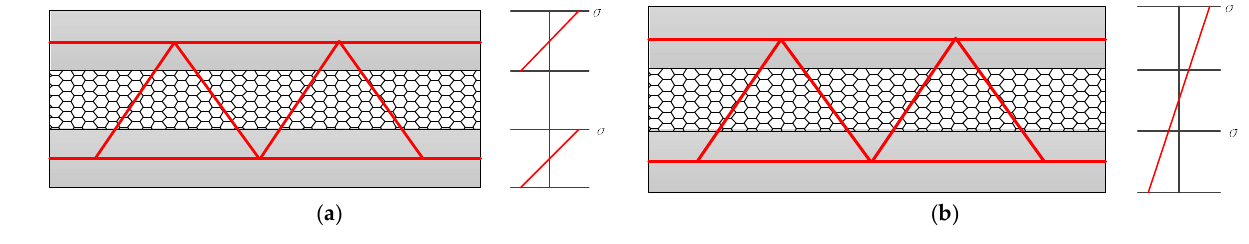
Figure 16. Strain distributions of the sandwich wall. ( a ) K = 0. ( b ) K = 1.